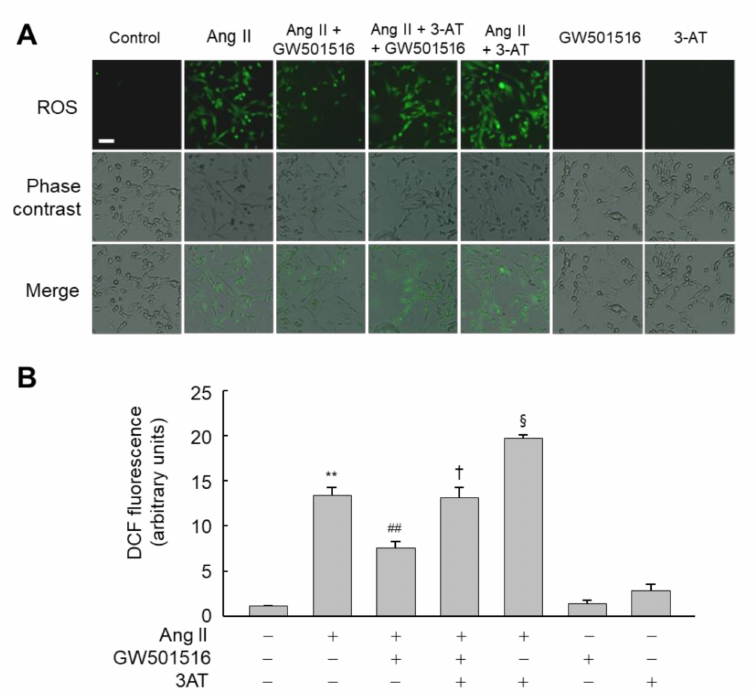
Figure 5. GW501516-activated PPAR δ suppresses Ang II-induced ROS accumulation through catalase in H9c2 cardiomyocytes. Cells were pretreated with 100 nM GW501516 and/or 30 mM 3-AT for 12 h, and then exposed to 100 nM Ang II for 2 h. Intracellular ROS accumulation was analyzed by fluorescence microscopy using 10 µ M CM-H2DCF-DA ( A ), and the fluorescence intensity was quantified ( B ). Representative images from four independent experiments are shown. Bars = 100 µ m. Results are expressed as mean ± standard error (SE) ( n = 4; ** p < 0.01 compared with the untreated group; ## p < 0.01 compared with the Ang II-treated group; † p < 0.05 compared with the Ang II and GW501516-treated group; § p < 0.05 compared with the Ang II, GW501516, and 3-AT-treated group). 3.4. Downregulation of Catalase Abrogates the Effects of PPAR δ on Hypertrophy and ROS Production To further confirm the role of catalase in PPAR δ -mediated suppression of hypertrophy and ROS generation stimulated by Ang II, the expression of catalase was knocked down by siRNA in H9c2 cardiomyocytes (Figure S4). GW501516 suppressed both Ang II-induced CSA and ROS generation in H9c2 cardiomyocytes, whereas siRNA-mediated knockdown of catalase significantly reversed the effect of GW501516 on both CSA and ROS accumulation in H9c2 cardiomyocytes exposed to Ang II (Figure 6). These findings indicate that PPAR δ inhibits Ang II-induced hypertrophy and ROS generation through